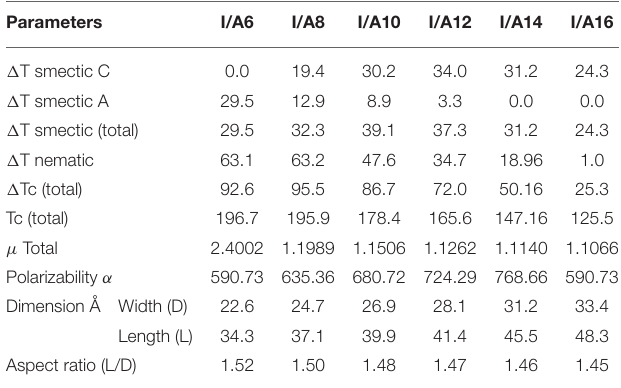
conformers of the di-nicotinate base and their prepared H - bonded complexes ( I/A n and II/A 6 ) , the results are tabulated in Table 2 . The results of the calculated thermal parameters